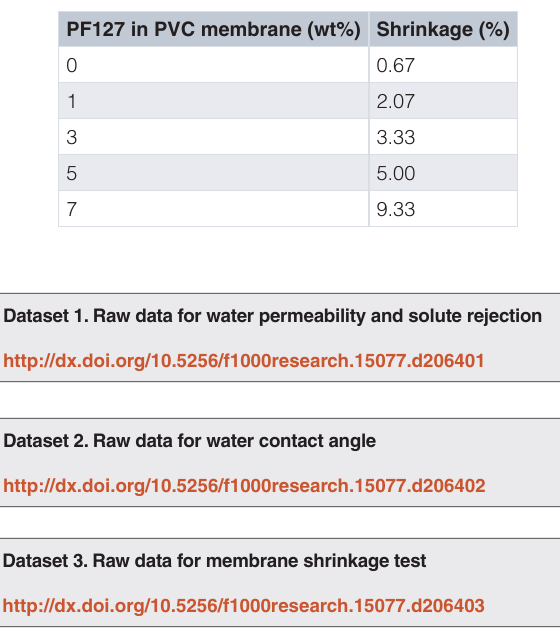
Table 1. Shrinkage observation of PVC membrane (n=3 per PF127 concentration). PF127 in PVC membrane (wt%) Shrinkage